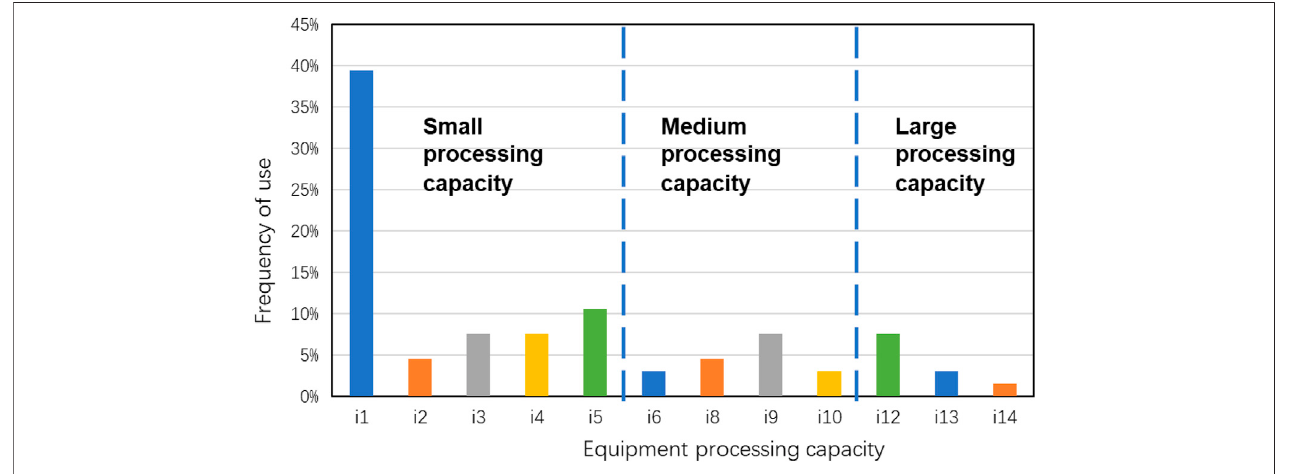
FIGURE 10 | Use frequency of modular